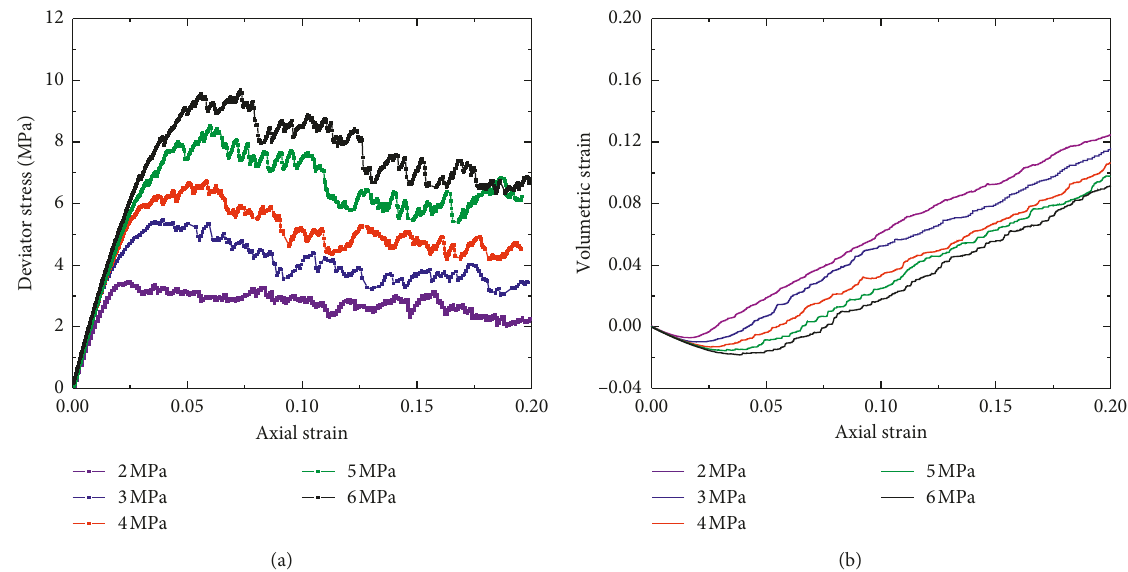
Figure 9: Simulation results of unbreakable samples subjected to biaxial compression: (a) deviator stress against axial strain; (b) volumetric strain against axial